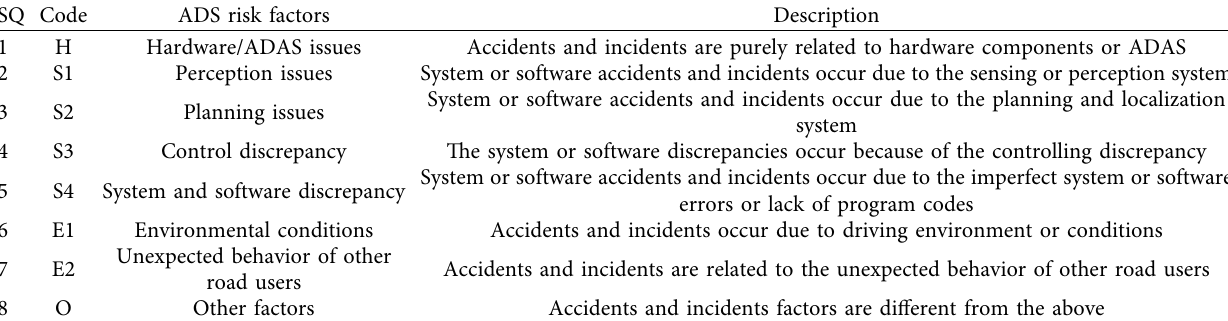
Table 3: Classifcation, defnitions, and descriptions of ADS risk factors and accident groups.